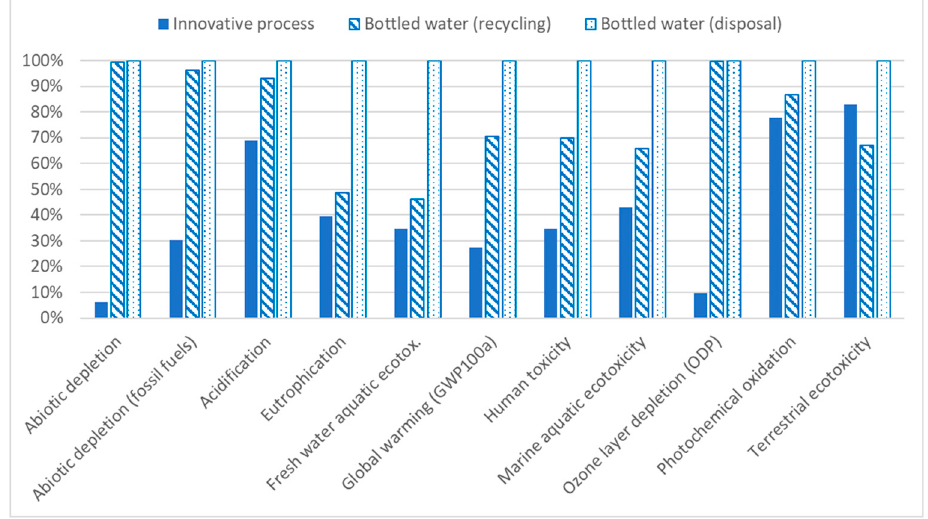
Figure 4. Potential environmental impact comparison between different water treatments: innovative process, use of bottled water with bottle recycling, and bottle disposal.